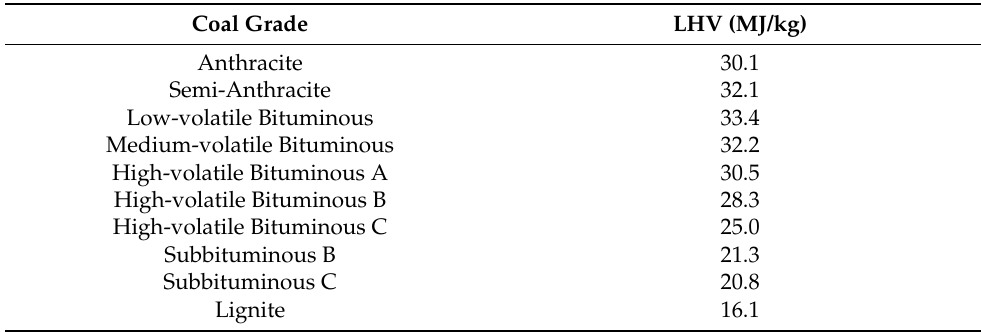
Table 7. Approximate lower heating values (LHV) of standard grades of coal (adapted from Refer- ences